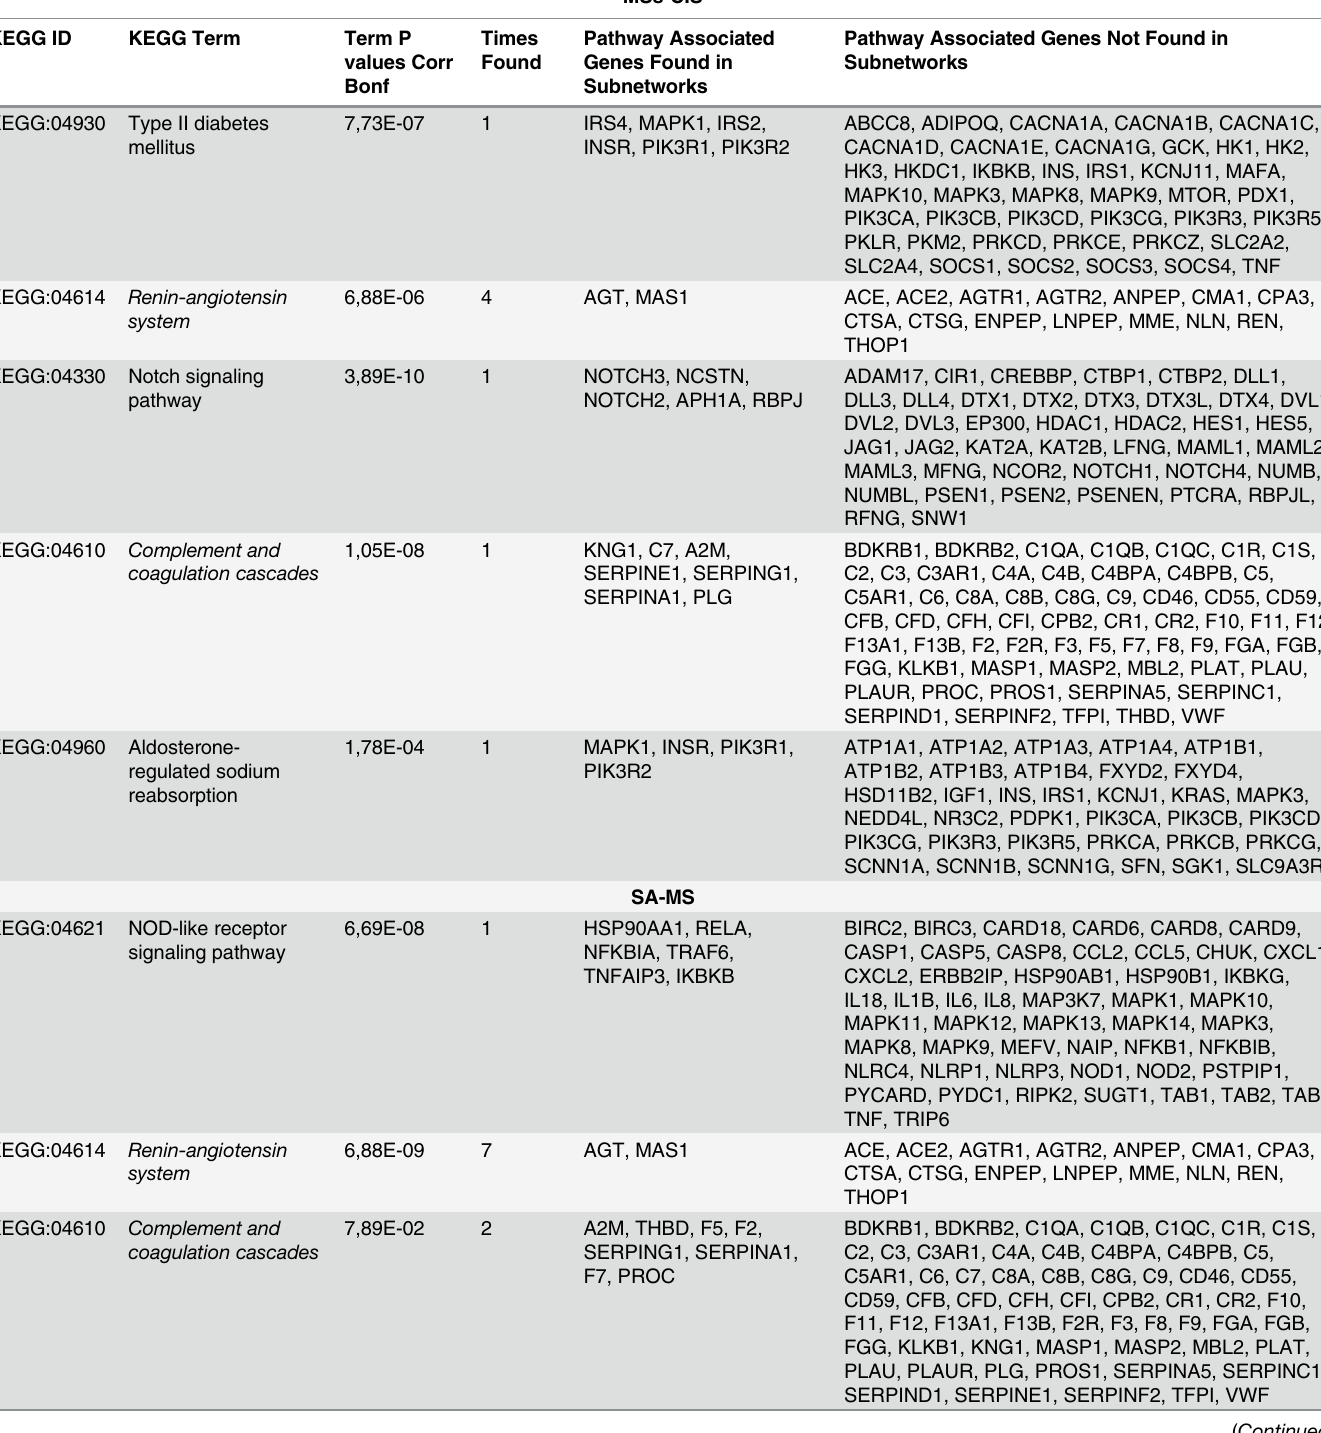
Table 5. Molecular pathways and associated proteins revealed by CIS subgroup